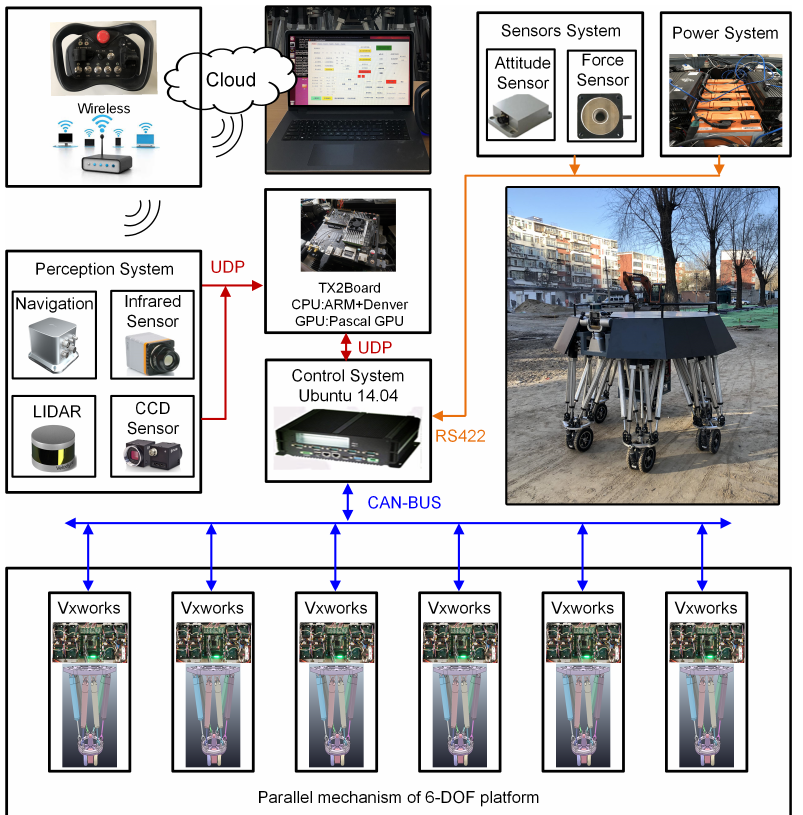
Figure 6. Hardware and software architecture of the robotic distributed system.